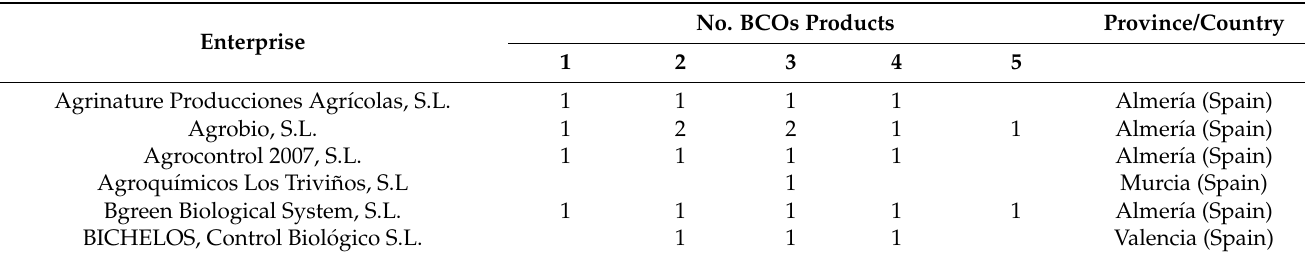
Table 4. Companies marketing BCOs products registered in Spain in 2022. Source: MAPA, [23].